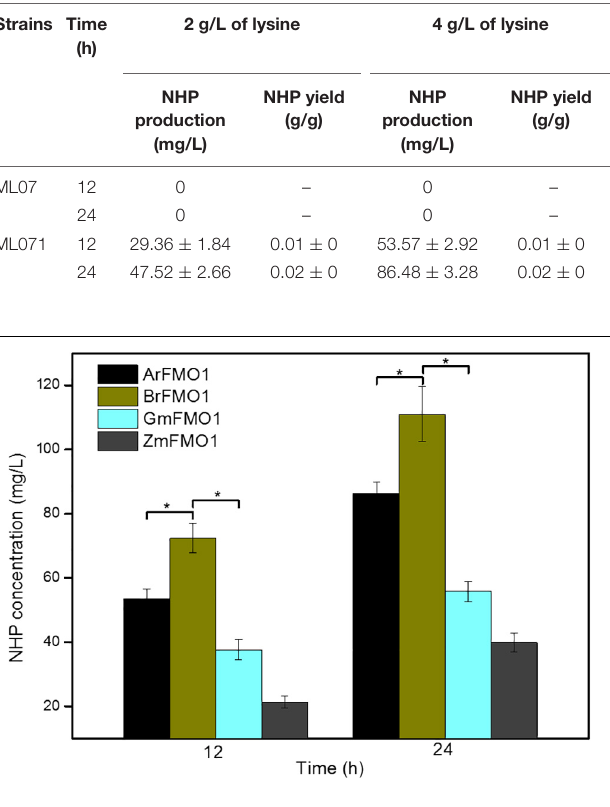
FIGURE 2 | Comparison of NHP synthesis by different FMO1s in E. coli strains. NHP production at 12 and 24 h by strains ML071, ML072, ML073, and ML074, supplemented with 4 g/L of lysine as substrate. Statistics were performed by two-tailed Student’s t -test. * p < 0.05. Each experiment was done at least in triplicate. Error bars indicate standard errors of the